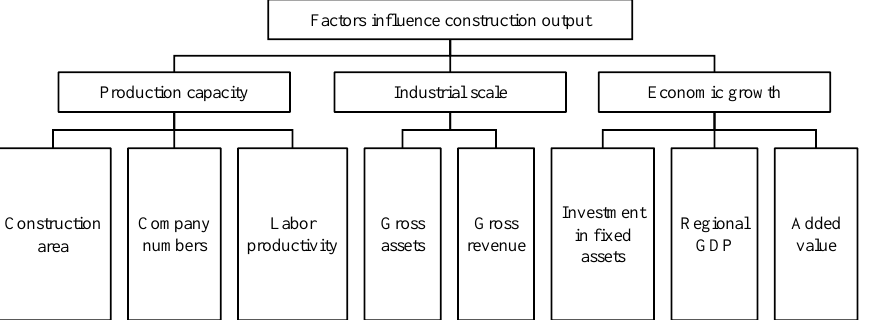
Figure 1. Factors influence construction output.